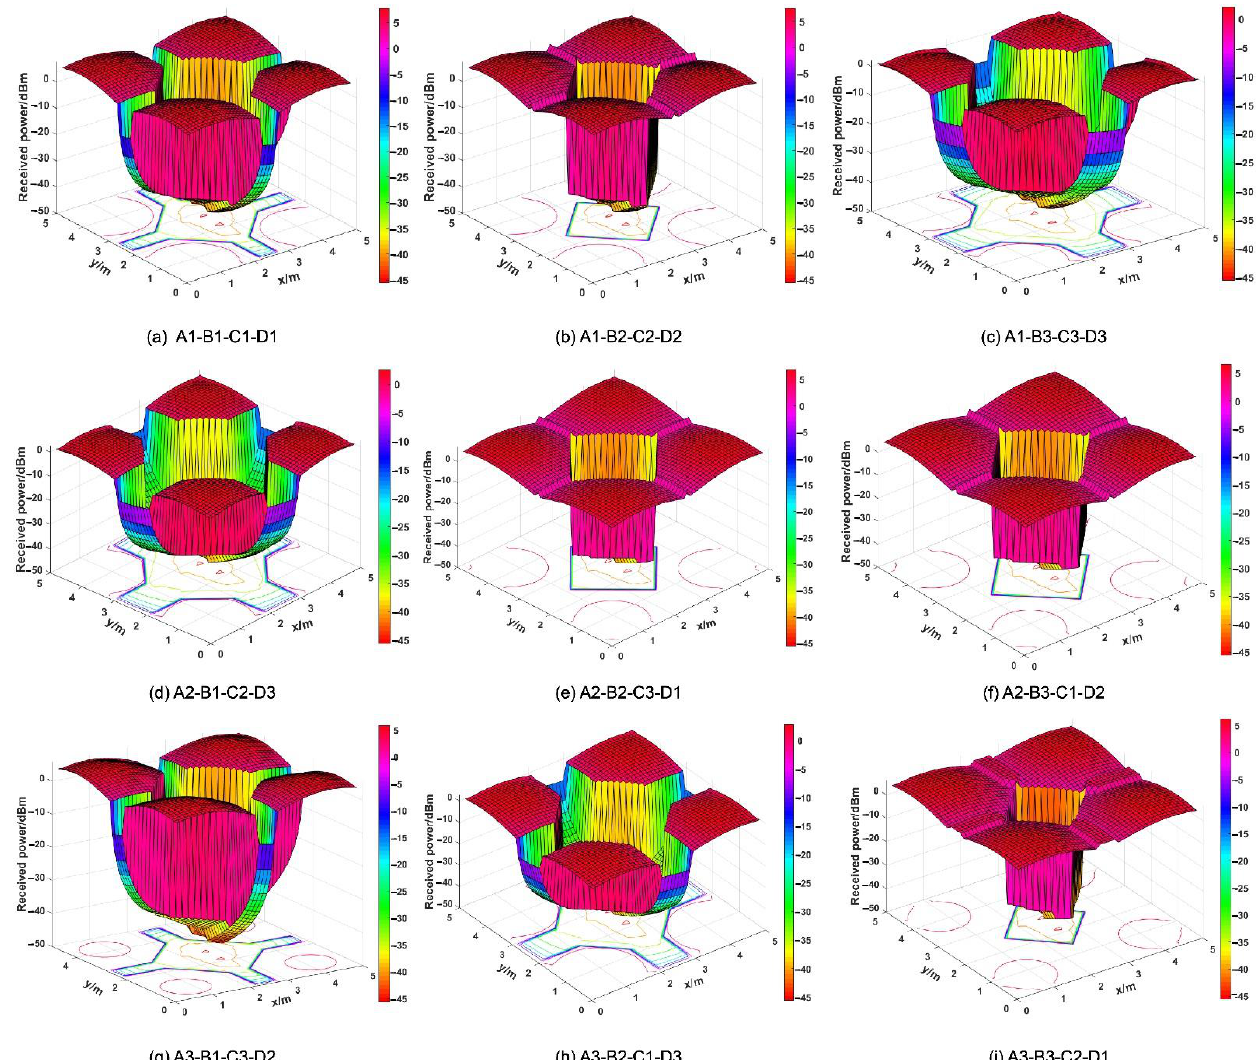
Figure 14. Diagram of the received power distribution for different parameter combinations.